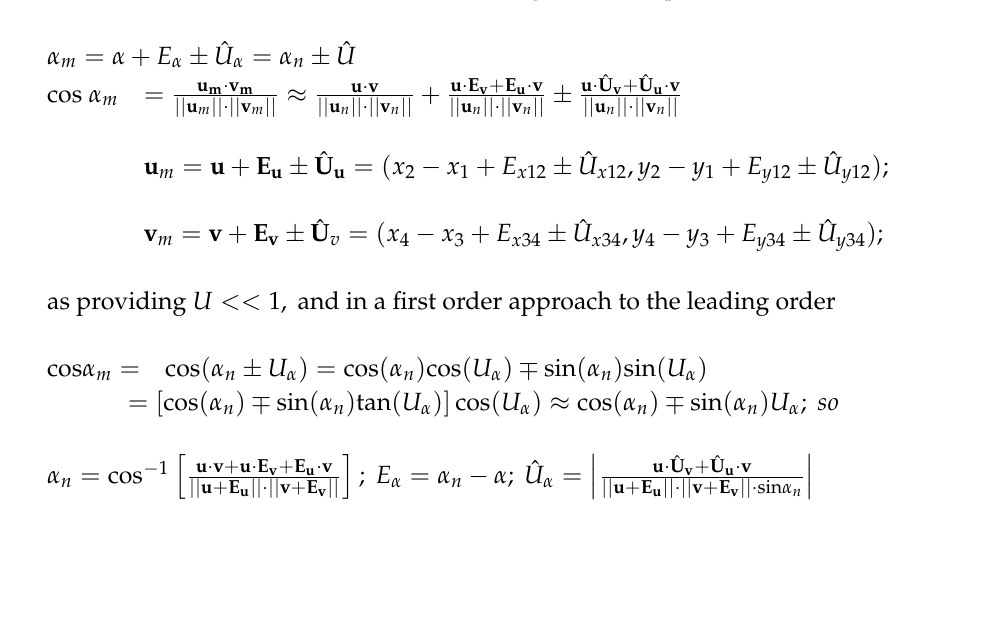
Figure 4. Minimum zone tolerance criteria of angle, ( a ) in the plane and ( b ) dihedral.